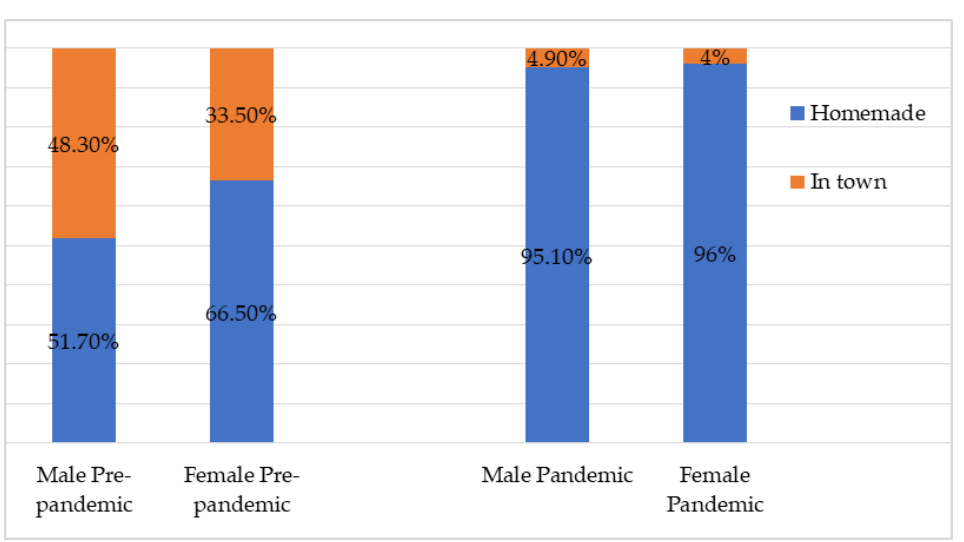
Table 4. The number of portions of vegetables and fruits per day.